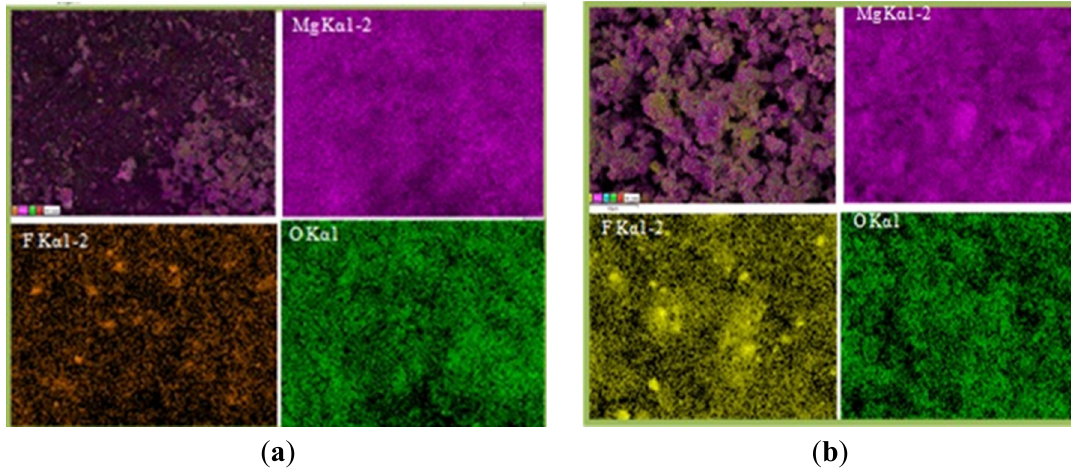
Figure 5. Elemental mapping showing particle morphology and distribution of 1 h milled MgH 2 + 5 mol% MgF 2 : ( a ) after desorption and ( b ) after re-hydrogenation at 335 °C.